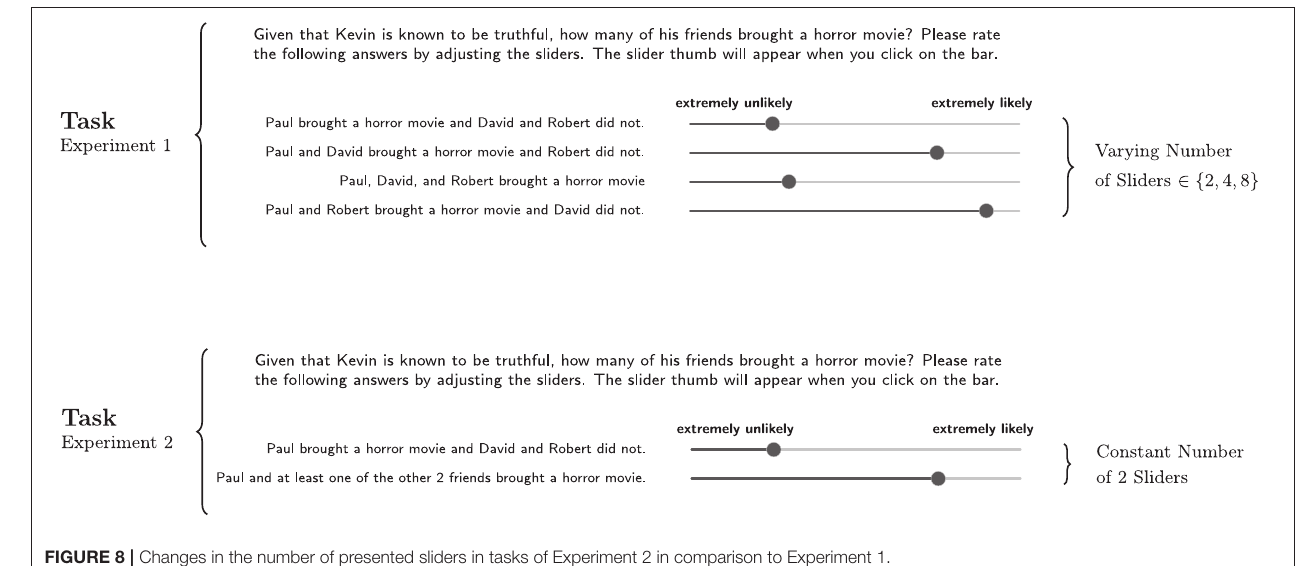
FIGURE 8 | Changes in the number of presented sliders in tasks of Experiment 2 in comparison to Experiment 1.